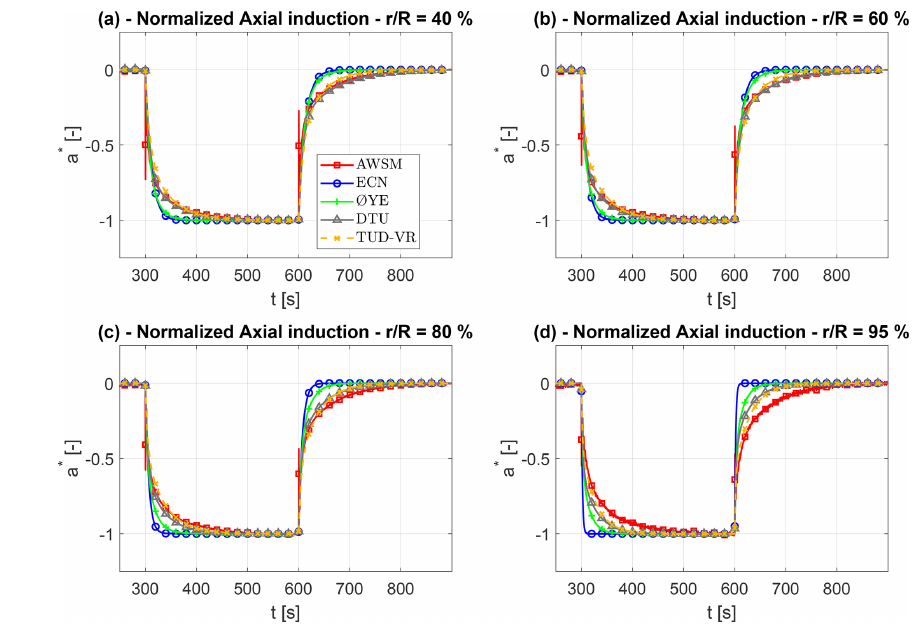
Figure 3. Normalized axial induction factor response to the pitch steps near rated conditions at four different radial locations: (a) 40% span, (b) 60% span, (c) 80% span, and (d) 95%